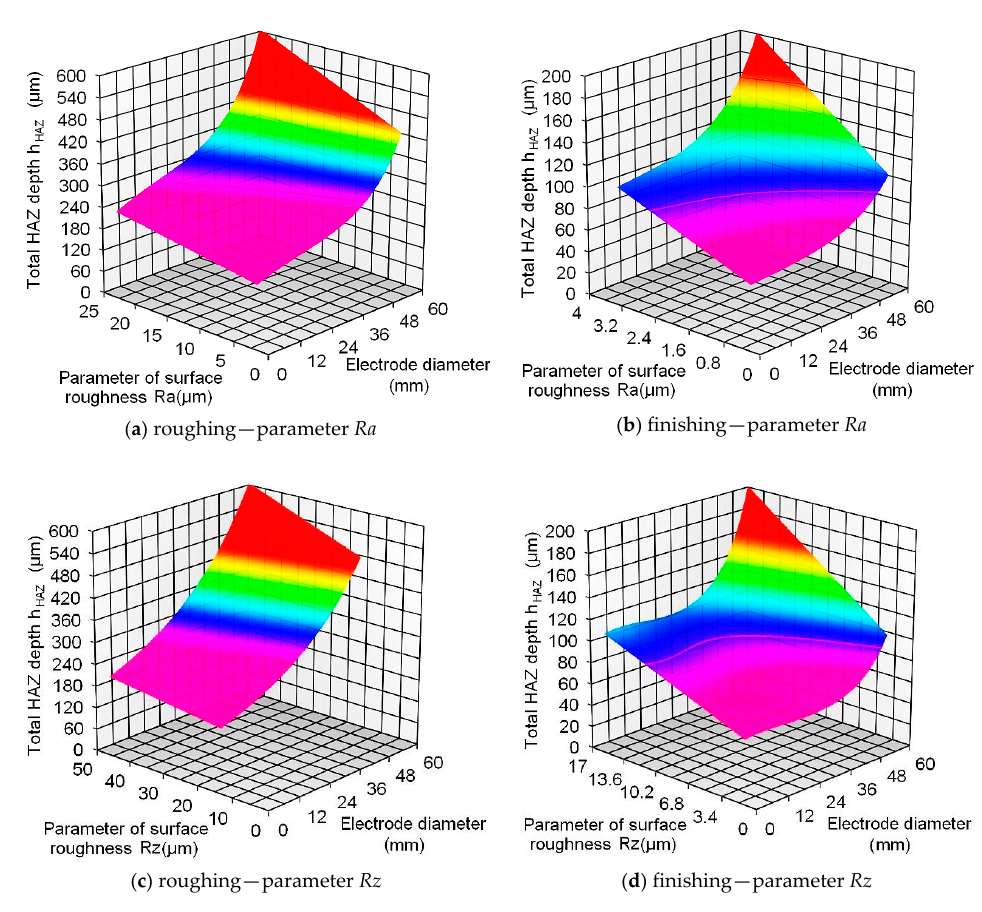
Figure 15. Graphical presentation of prediction of total thickness h HAZ of tool steel EN X32CrMoV12 ‐ 28 after die ‐ sinking EDM with a SF ‐ Cu electrode in dependence of machined surface roughness parameters Ra and Rz for an eroded surface of a round cross ‐ section with diameter ranging from 5 to 60